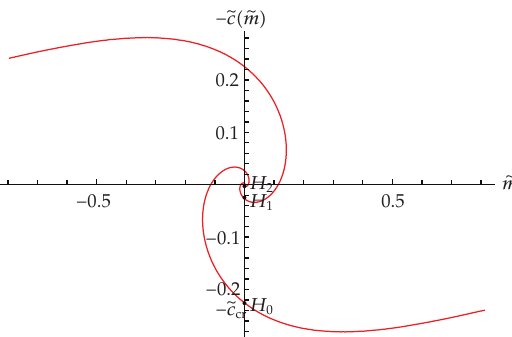
Figure 3: A magnification of Figure 2 shows the spiral behavior near the origin of the (cid:3) − (cid:5) c, (cid:5) m (cid:4) -plane. The second (cid:3) left (cid:4) spiral arm represents the (cid:3) (cid:5) m, − (cid:5) c (cid:4) → (cid:3) − (cid:5) m, (cid:5) c (cid:4) symmetry of the